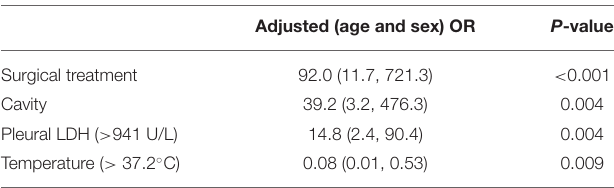
TABLE 3 | Age- and sex-adjusted OR for risk factors associated with TE in childhood pleural TB. Adjusted (age and sex) OR P -value Surgical